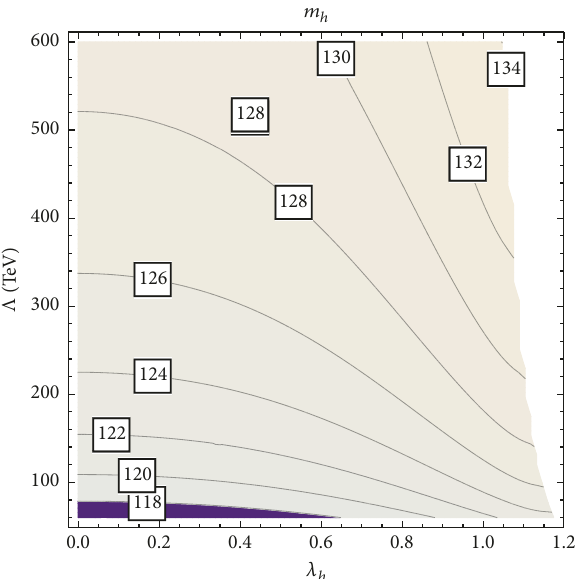
Figure 1: Distribution of Higgs mass in [𝜆 ℎ , Λ] plane.